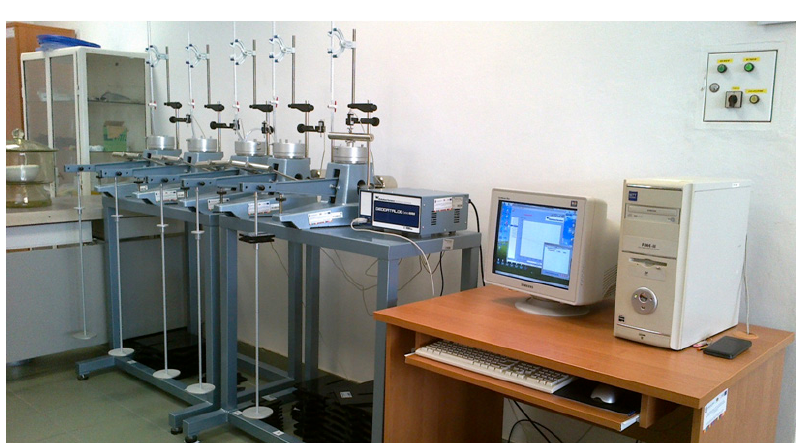
Figure 2. Set of